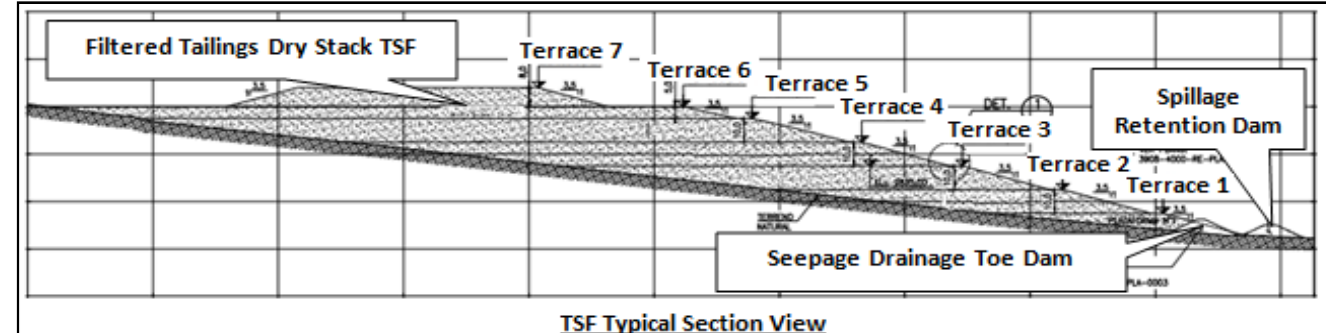
Figure 11. Typical Dry Stack TSF Geometrical Configuration—Typical Cross Section View [18].